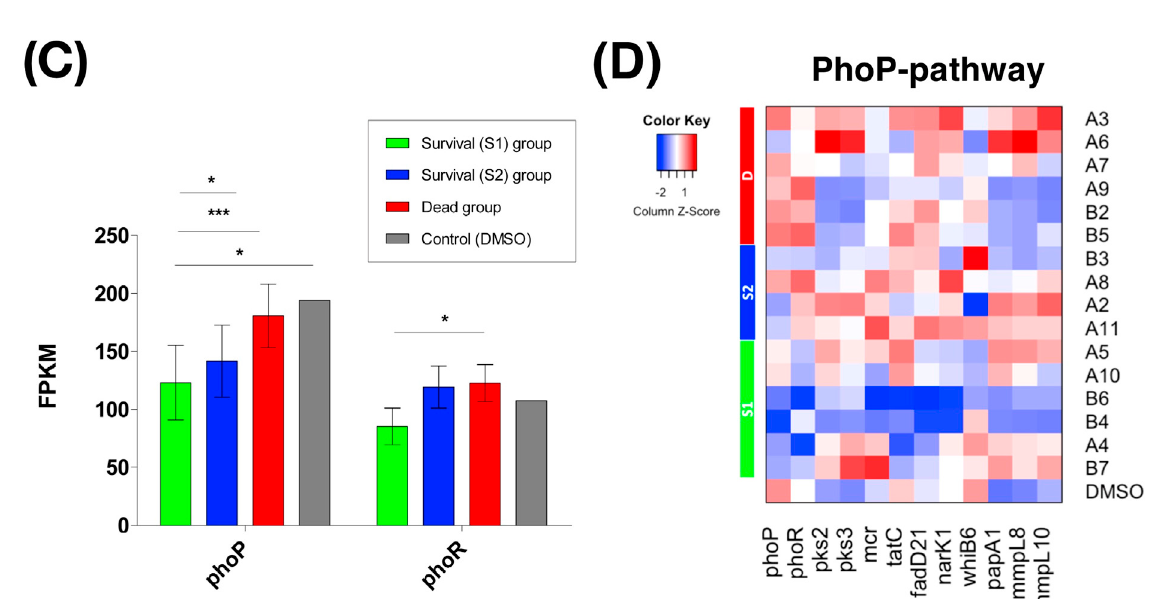
Figure 3. RNA ‐ Seq transcriptome analysis and representative genes involved in the phoP ‐ pathway. ( A ) Principal component analysis (PCA) of BCGs after treatment with 16 compounds in 3 groups based on the gene expression detected in all samples. ( B ) Heatmap showing a clustering analysis of gene expression levels for the three groups of BCGs ( p < 0.05, FC > 2 or < 0.5). ( C ) Expression of phoP and phoR in S1, S2, D, and the control groups. Data are presented as means ± SD ( n = 6 for S1 and D, n = 4 for S2, and n = 1 for the control group) and were analyzed using a two ‐ way ANOVA, * p < 0.05, *** p < 0.001, while those without a label have no significances. ( D ) The expression of genes regulated by phoP/R in BCGs after treatment with the 16 compounds.